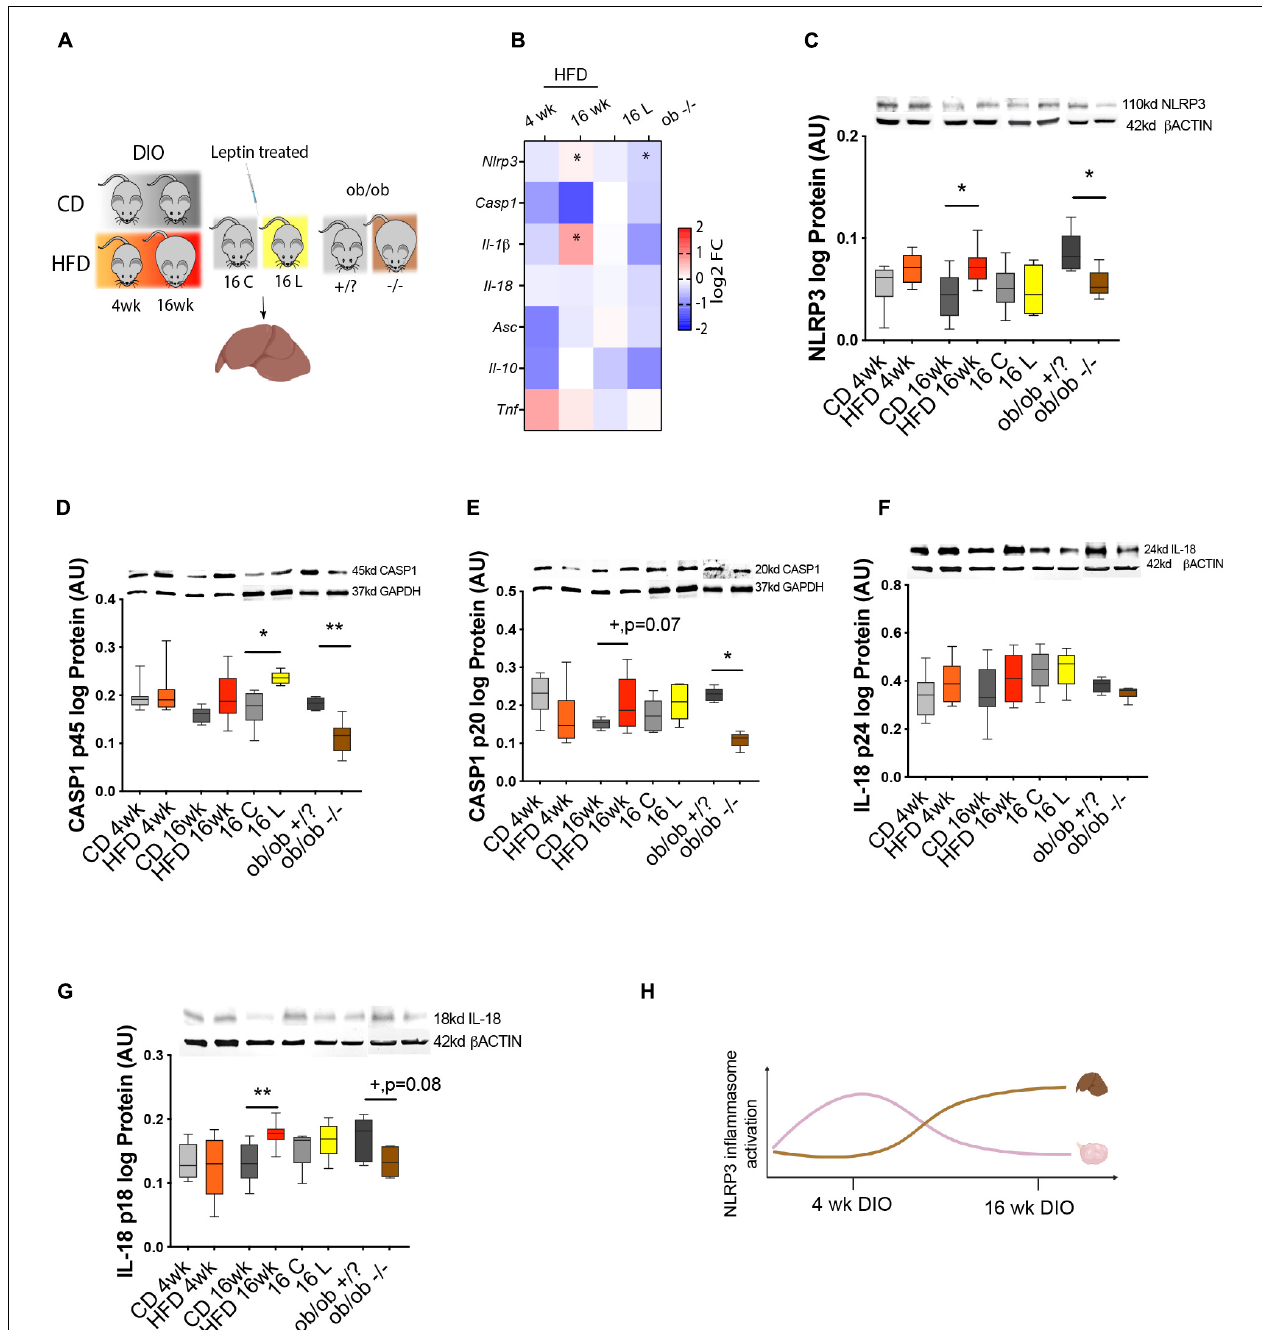
FIGURE 5 | NLRP3 activity in the liver of DIO, hyperleptinemic, and genetically obese mice. (A) Experimental design: (i) DIO mice were fed CD or HFD for 4 or 16 week; (ii) pharmacologically hyperleptinemic mice were treated with saline (C) or 100 µ g of leptin (L) for 16 days; (iii) genetically obese mice lacking leptin ( ob/ob − / − ) and control group ( ob/ob +/?). (B) Heatmap illustrating fold change in expression of mRNA of genes Nlrp3 , Casp1 , Il-1 β , and Il-18 , Asc , Il-10 , and Tnf in DIO, hyperleptinemia, and ob/ob models in comparison with respective controls, determined by real-time PCR. The scale on the right matches colors to log2 fold change (log2 FC) values. Data normalized to mRNA expression of ribosomal protein L37 ( Rpl37 ). Abundance of (C) NLRP3, (D) pro CASP1 p45, (E) CASP1 p20, (F) pro IL-18 p24, and (G) IL-18 p18 in mouse liver of DIO, hyperleptinemic, and ob/ob mice measured in Western blotting analysis. Protein normalized with β -actin or glyceraldehyde 3-phosphate dehydrogenase (GAPDH) level. Bars represent mean ± SEM. Statistical analysis between groups was carried out using Mann–Whitney test. Number of samples: n = 6–9 for real-time PCR analysis and n = 4–8 for immunoblots. Asterisks indicate significant differences (* p < 0.05; ** p < 0.01; + p = 0.07; + p = 0.08—all values indicated). AU, arbitrary units. (H) Diagram summarizing the profile of NLRP3 inflammasome activation in ovaries and liver of DIO mice. Figure 5H created with BioRender.com.